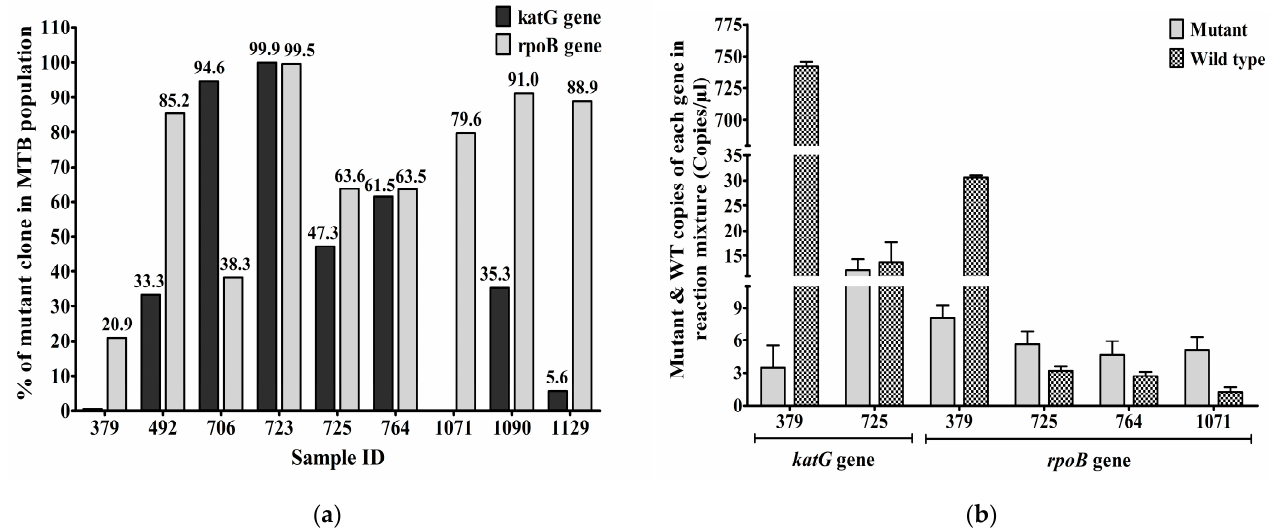
Figure 4. ( a ) The percentage of katG and rpoB mutant strains (Mean ± SEM) in the MTB populations from 9 DR-TB cases based on sputum samples; ( b ) Mutant and WT copies (Mean ± SEM) of katG and rpoB genes in DR-TB cases. Heteroresistance due to mutations in either or both the katG gene and the rpoB gene was detected in new TB cases. Mean ± SEM is shown with error bars, where SEM is computed by dividing standard deviation (SD) by the square root of the count